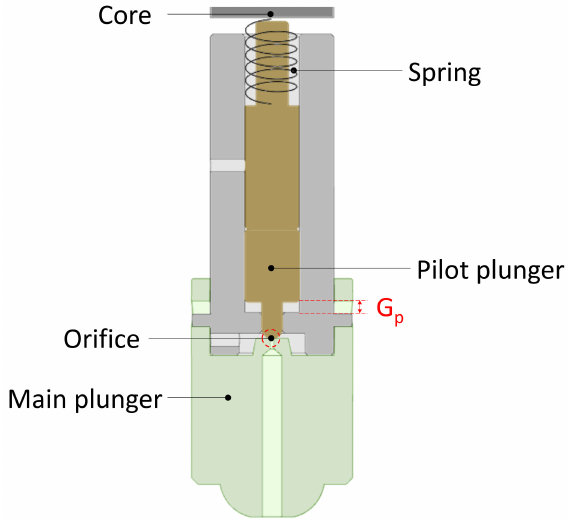
Figure 1. Schematic of the pilot-operated solenoid